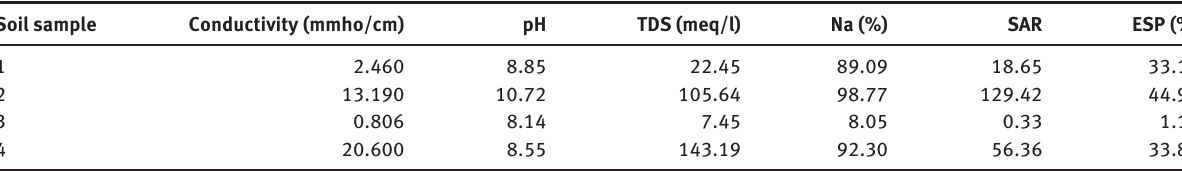
Table 2 Chemical compositions of the soil used in the study. Soil